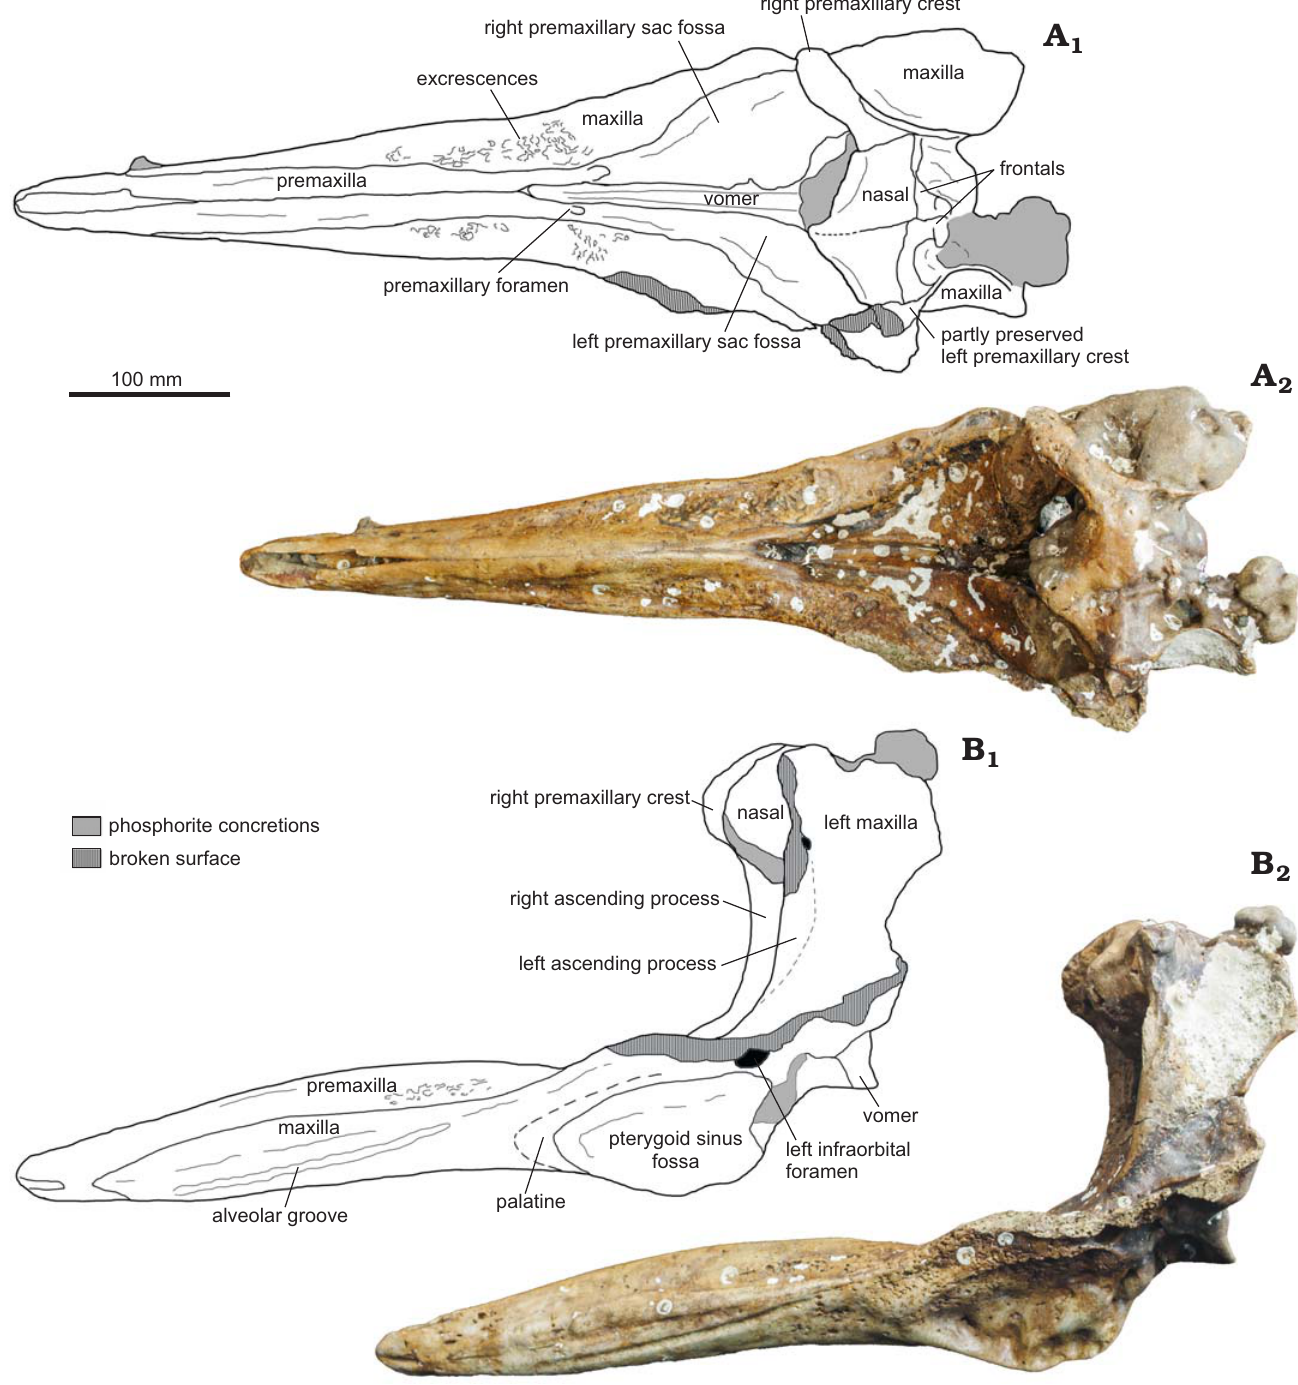
Fig. 1. Partial cranium of a beaked whale Beneziphius cetariensis sp. nov., holotype (SGHNMF MA0953) from the middle Miocene to early Pliocene of A Selva fishing ground, off the Galician coast, Spain, in dorsal ( A ) and left lateral ( B ) views. Interpretive drawings (A 1 , B 1 ) and photographs (A 2 , B 2 (Fig. 1A). In lateral view, the maximum elevation of the 50 mm (Figs. 1, 2), a difference with Beneziphius breviros- premaxillae is approximately at half the rostrum length. tris and Choneziphius planirostris (both latter taxa having The premaxillae are separated anteriorly for 120 mm, re- vealing an open mesorostral groove (transverse diameter 12 mm) as observed in B. brevirostris , Choneziphius leidyi , Messapicetus , and Ziphirostrum . Backwards, the premax- illae diverge abruptly 30 mm anterior to the premaxillary